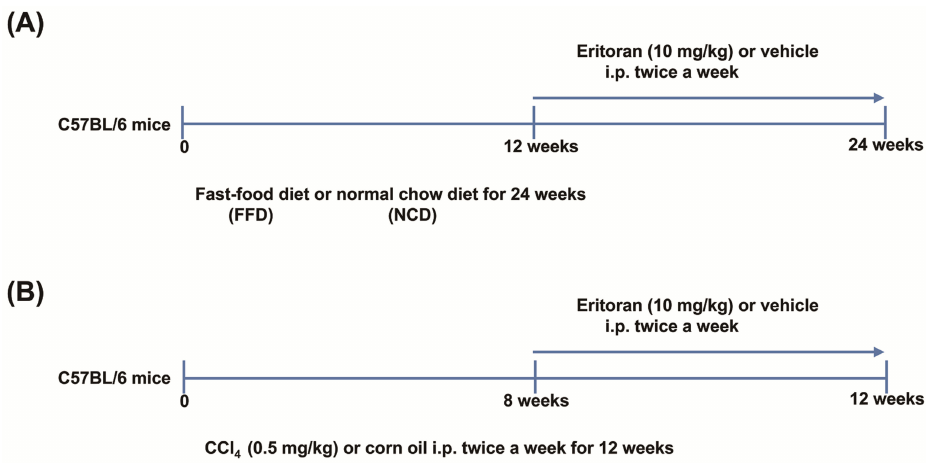
Figure 1. The experimental protocols of animal studies. ( A ) C57BL/6 mice were fed a fast-food diet (FFD) or normal chow diet (NCD) for 24 weeks. After 12 weeks of FFD or NCD feeding, the mice were randomly assigned to receive eritoran (E: 10 mg/kg) or the vehicle (V: 100 µ L normal saline) twice a week via intraperitoneal injection for 12 weeks with continuous FFD or NCD feeding (NCD-V: n = 6; NCD-E: n = 6; FFD-V: n = 10; FFD-E: n = 9). ( B ) C57BL/6 mice were intraperitoneally administered carbon tetrachloride (CCl 4 ) (0.5 mg/kg body weight twice a week) or corn oil (control, Ctrl) for 12 weeks. After eight weeks of CCl 4 or corn oil treatment, the mice were randomly administered eritoran (E: 10 mg/kg) or the vehicle (V: 100 µ L normal saline) intraperitoneally twice a week for four weeks, with continuous CCl 4 or corn oil treatment (Ctrl-V/Ctrl-E: n = 8; CCl 4 -V/CCl 4 -E: n =